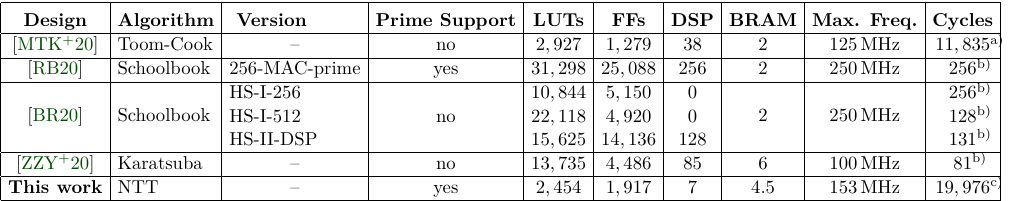
Table 3: Resource and performance comparison for polynomial multiplication alternatives for Saber n = 256 (measurements of this work evaluated for Artix 7 FPGA XC7A100T).